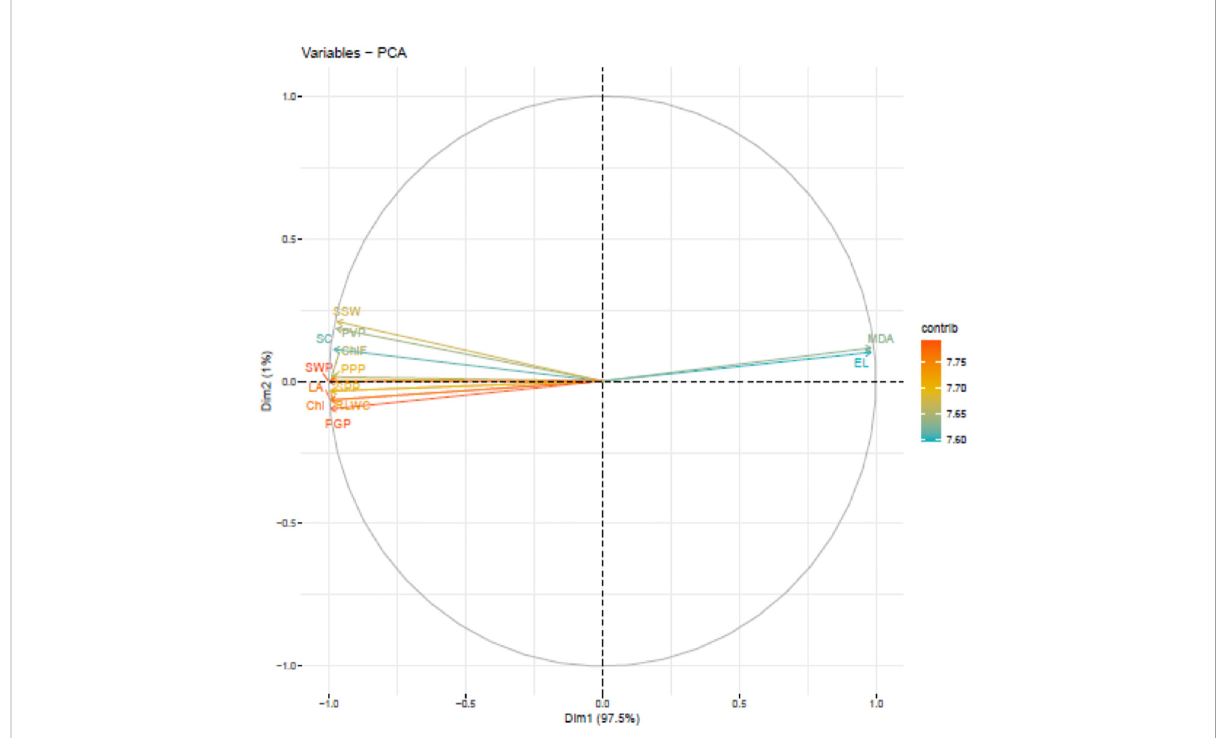
FIGURE 7 Principal component analysis (PCA) of various traits in urdbean genotypes under heat stress in a growth